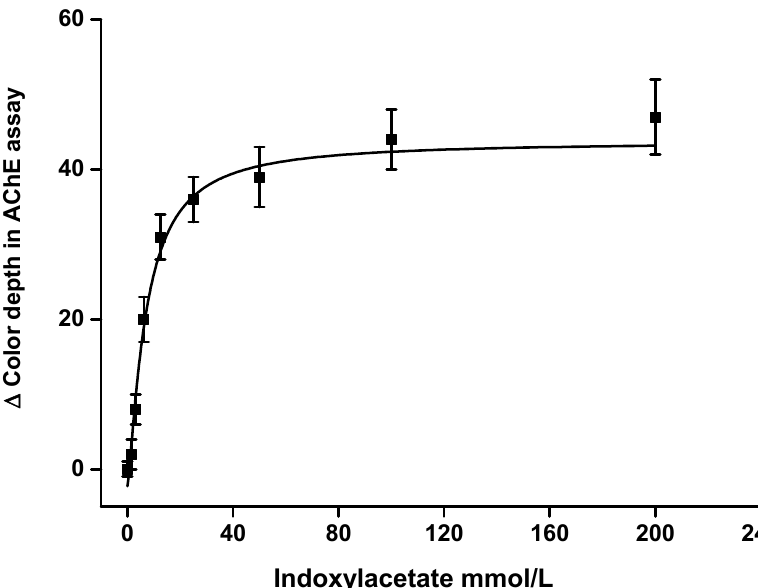
Figure 3. Saturation curve for indoxylacetate applied on a measuring pad with acetylcholinesterase (AChE) 50 µkat/mL. The concentration is expressed for 10 µL of sample. R (red) channel and 60 min incubation were chosen for this experiment. Standard error of the mean is expressed for five independent repeats.